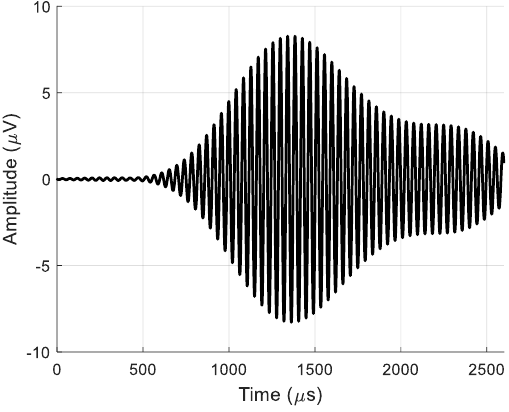
Figure 25. Signal from virtual air-coupled receiving array obtained after 2D spatial – temporal filtering at x = 55.1 mm.